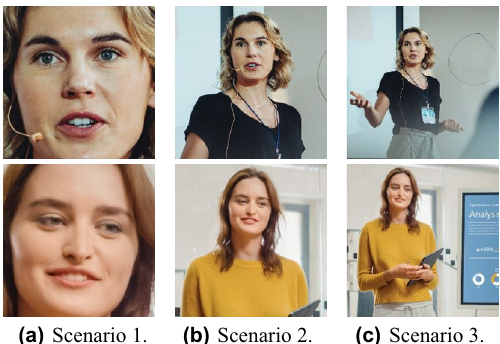
Figure 5. Sample images by the